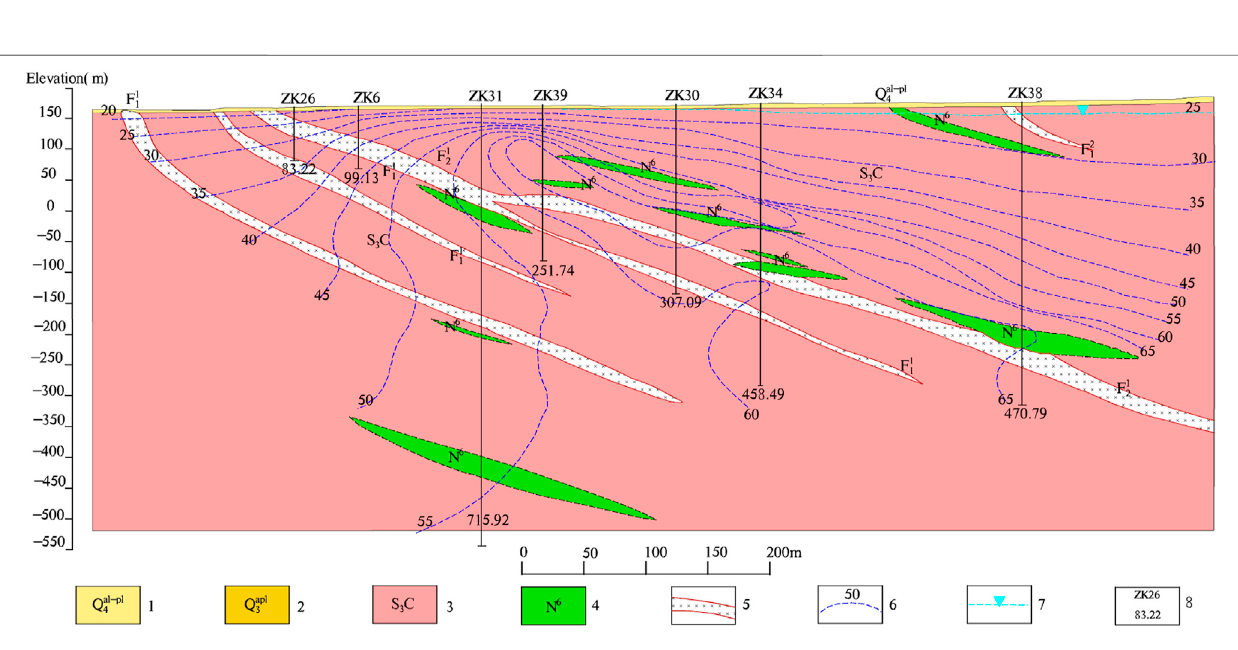
Frontiers in Earth Science |